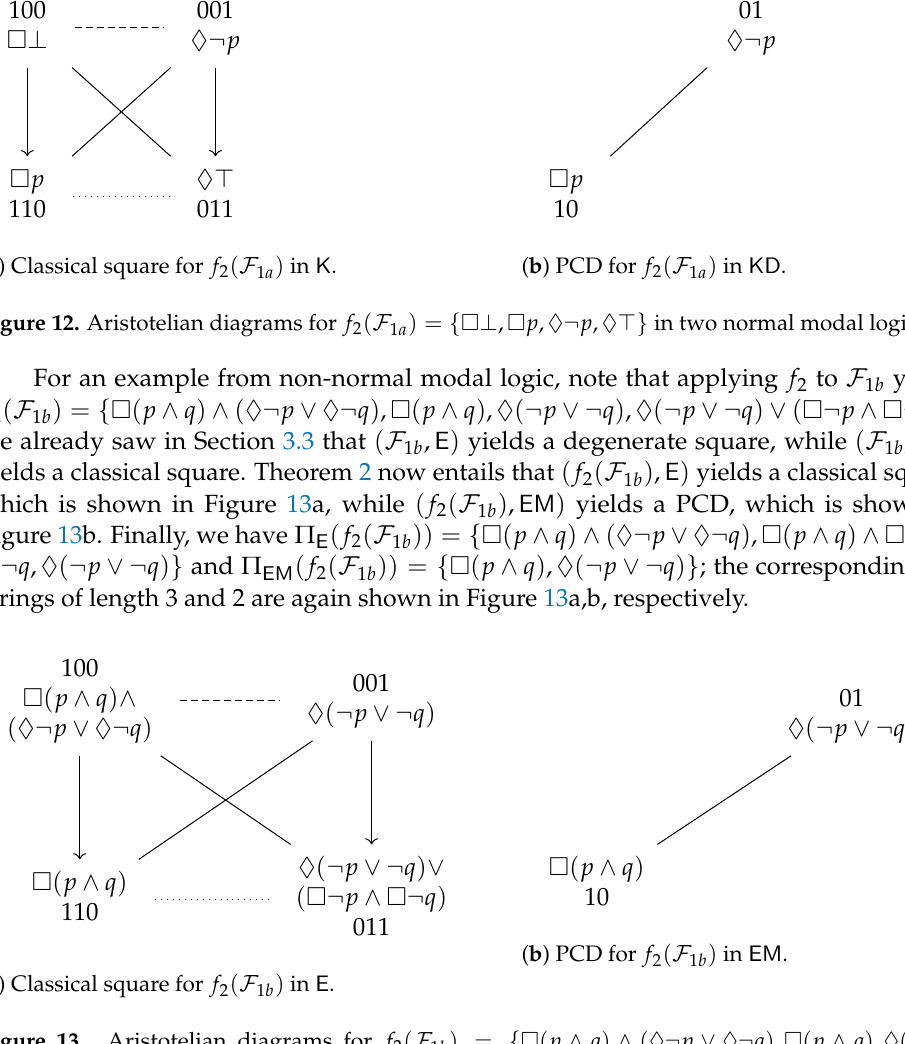
Figure 13. Aristotelian diagrams for f 2 ( F 1 b ) = { (cid:3) ( p ∧ q ) ∧ ( ♦ ¬ p ∨ ♦ ¬ q ) , (cid:3) ( p ∧ q ) , ♦ ( ¬ p